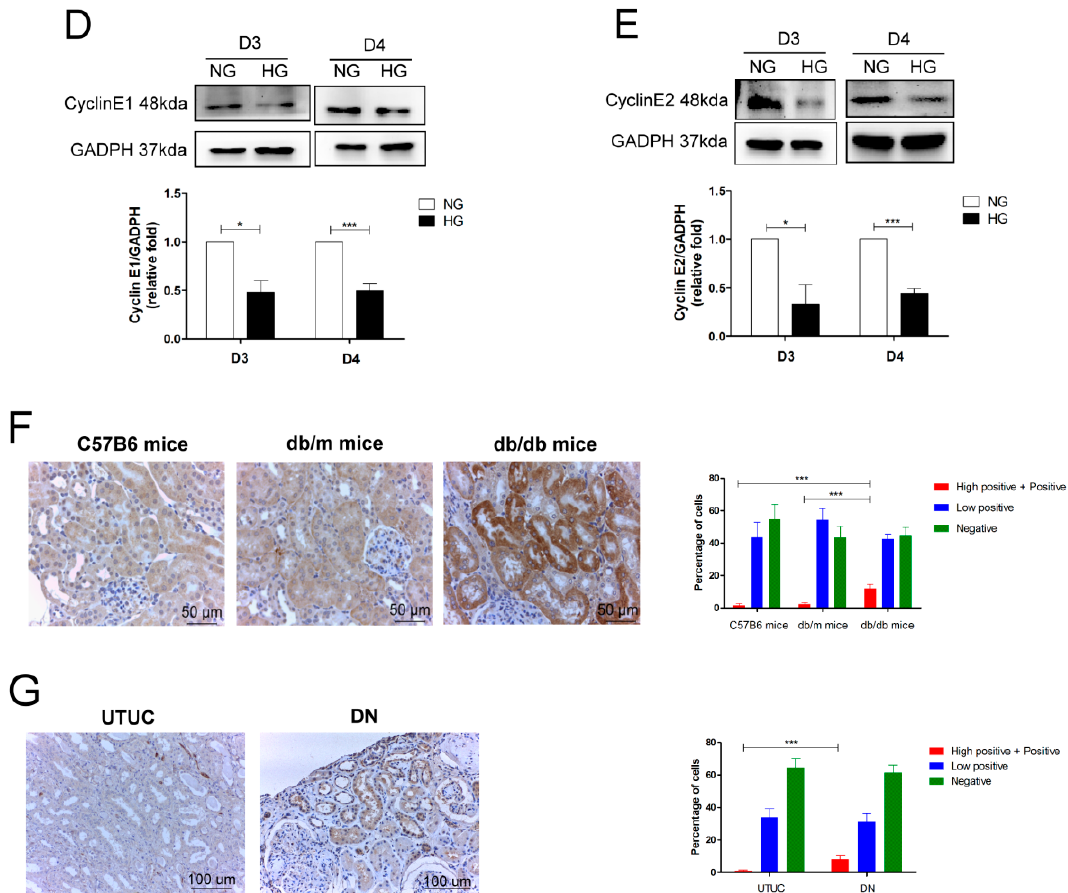
Figure 1. High glucose (HG) induces cell senescence in proximal tubular epithelial cells (PTECs). ( A ) The effect of HG on morphological changes and senescence-associated β -galactosidase (SA β -Gal) staining of human PTECs. PTECs were incubated under normal glucose (NG, 6.2 mM) and HG (30 mM) conditions for seven days and nine days. Cell senescence was assessed using SA β -Gal staining. HG increased p53 ( B ) (D3: n = 6, D4: n = 4) and p27 ( C ) (D3: n = 3, D4: n = 3), and decreased cyclin E1 ( D ) (D3: n = 3, D4: n = 4) and cyclin E2 ( E ) (D3: n = 3, D4: n = 4) protein expression in human PTECs after three and four days of treatment. Protein levels were assessed by western blot. The expression of p53 in the proximal tubule of kidneys of mice ( F ) and humans ( G ). The kidney sections of C57BL/6 mice, non-diabetic db/m mice, and diabetic db/db mice, and human donors (upper tract urothelial carcinoma, UTUC with normal kidney function and normal glomerulus and proximal tubule) and patients with diabetic nephropathy (DN) were stained with p53 (brown). The images quantification was performed using the IHC Profiler Plugin of ImageJ Software. The bar graph represents the mean ± S.E.M. * p < 0.05, ** p < 0.01, *** p < 0.001 by Student’s t test.